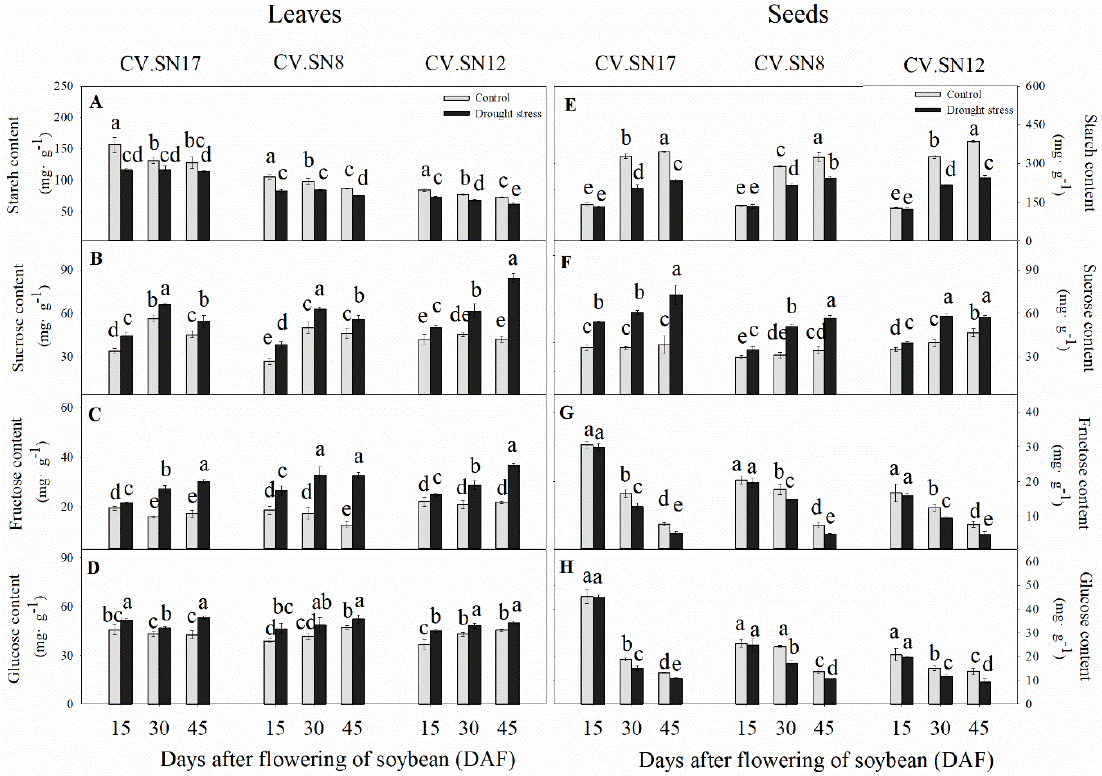
Figure 2. Effect of drought stress on the ( A , E ) starch, ( B , F ) sucrose, ( C , G ) fructose, and ( D , H ) glucose contents of leaves and seeds. Standard deviations were calculated with three independent experiments each comprising two soybean plants. Different letters above vertical bars indicate significant differences between means at a p < 0.05 level.